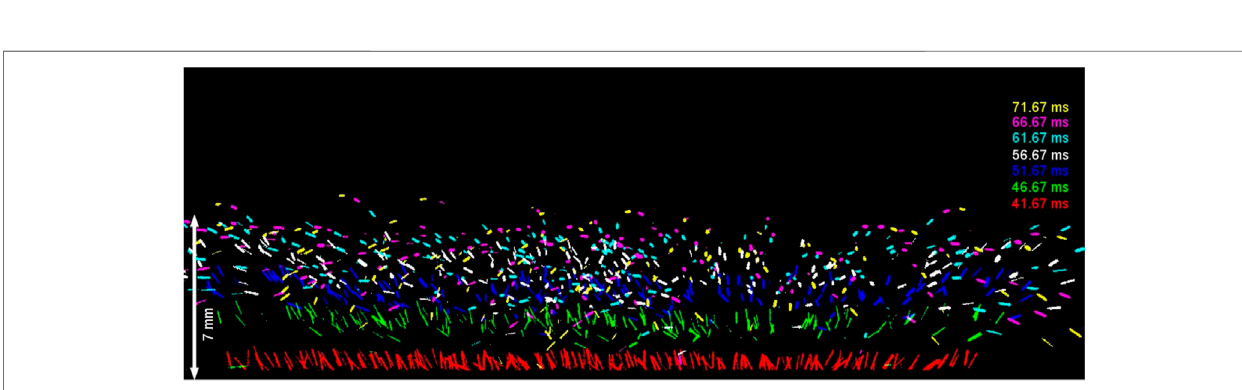
Frontiers in Physics |